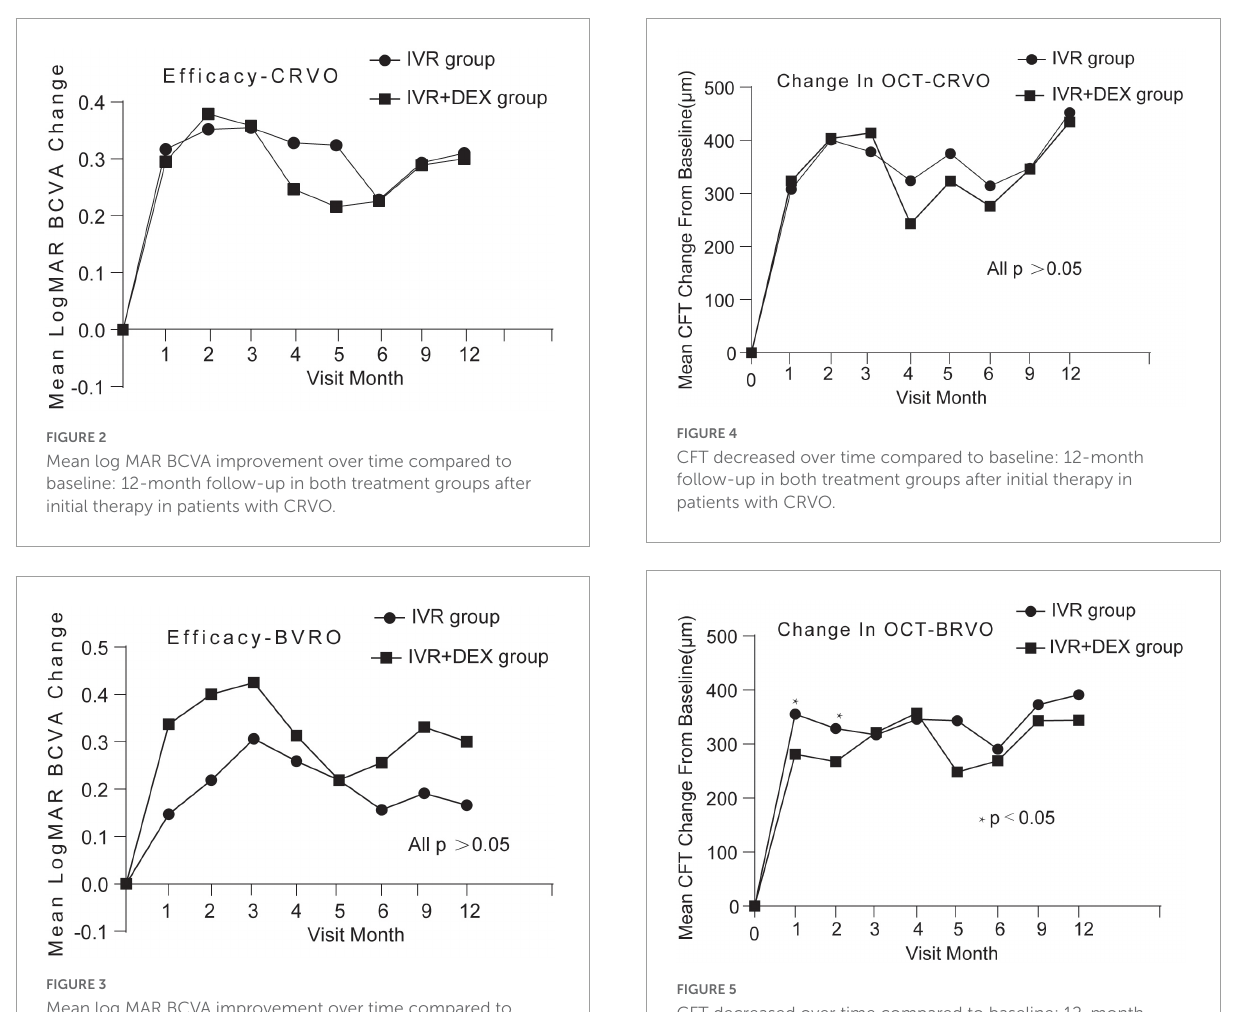
FIGURE3 Mean log MAR BCVA improvement over time compared to baseline: 12-month follow-up in both treatment groups after initial therapy in patients with BRVO.